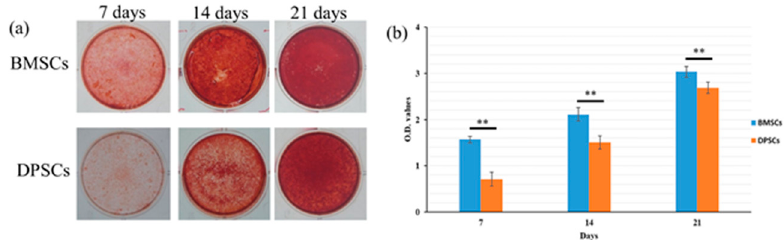
Figure 4. Comparison of osteogenic differentiation capacities of BMSCs and DPSCs. ( a ) Mineral depositions of BMSCs and DPSCs were detected by alizarin red staining following 7, 14, and 21 days of osteogenic induction. ( b ) The BMSCs showed a higher osteogenic differentiation ability than the DPSCs with statistically significant differences at different time points (* p < 0.05, ** p < 0.01).